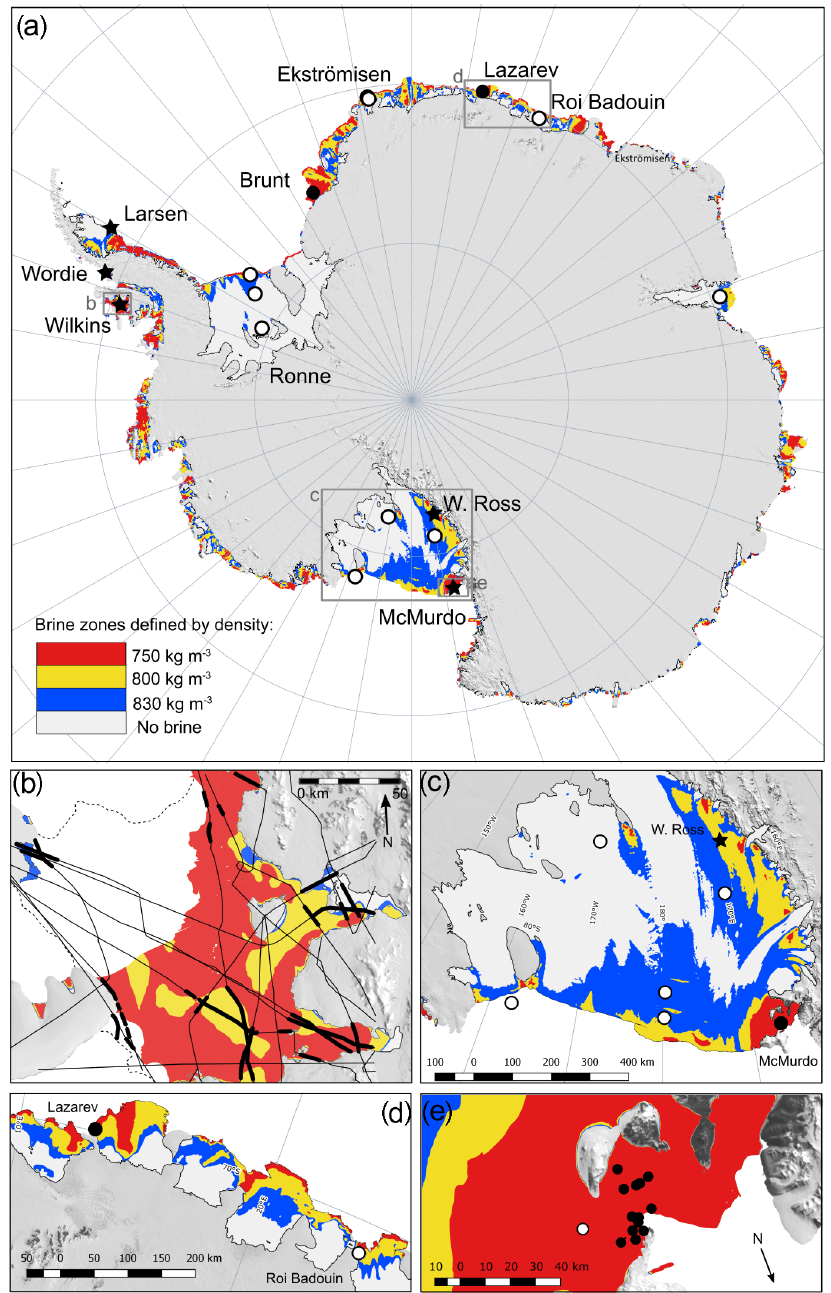
Figure 2. Previous observations of firn and brine around Antarctica. Coloured areas show potential brine zones as described in Fig. 1. Closed circles indicate boreholes where brine has been observed. Open circles are firn cores which penetrated below sea level but found no brine. Observations of brine using ice-penetrating radar are marked with black stars. Grey boxes on the main map indicate the extent of regions mapped in subfigures: (b) Wilkins Ice Shelf, (c) Ross Ice Shelf, (d) Princess Ragnhild Coast and (e) McMurdo Ice Shelf. Panel (b) is adapted from (Vaughan et al., 1993) with thin black lines showing the full network of radar flight paths over the ice shelf. Thick black lines indicate areas where no brine was detected. Observations are described in detail in Tables S4 and